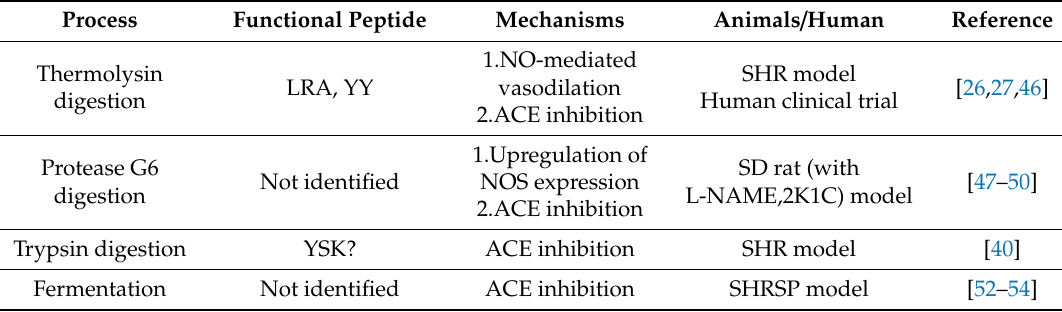
Table 1. Summary of the anti-hypertensive e ff ects of processed rice